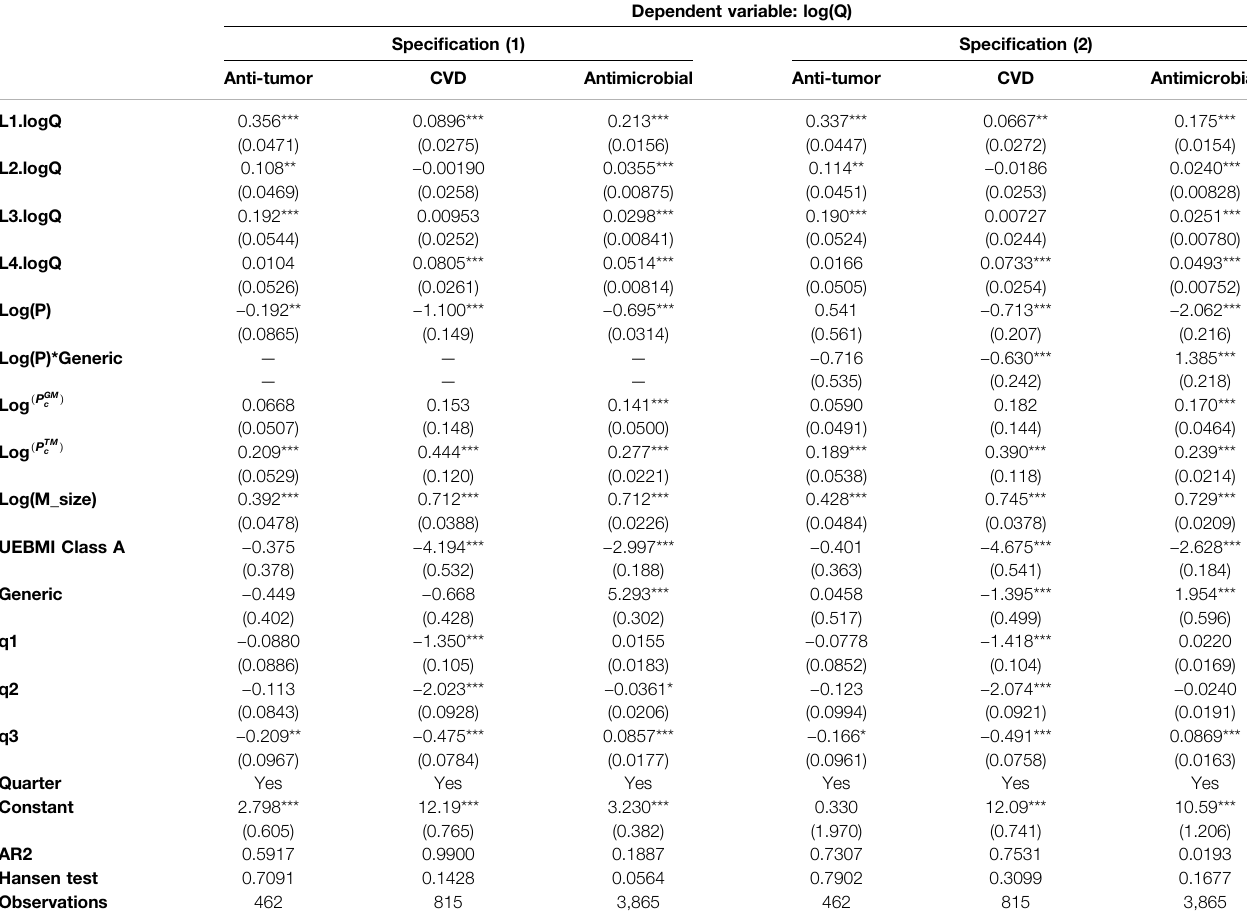
TABLE 3 | Estimates of the demand by therapeutic drug